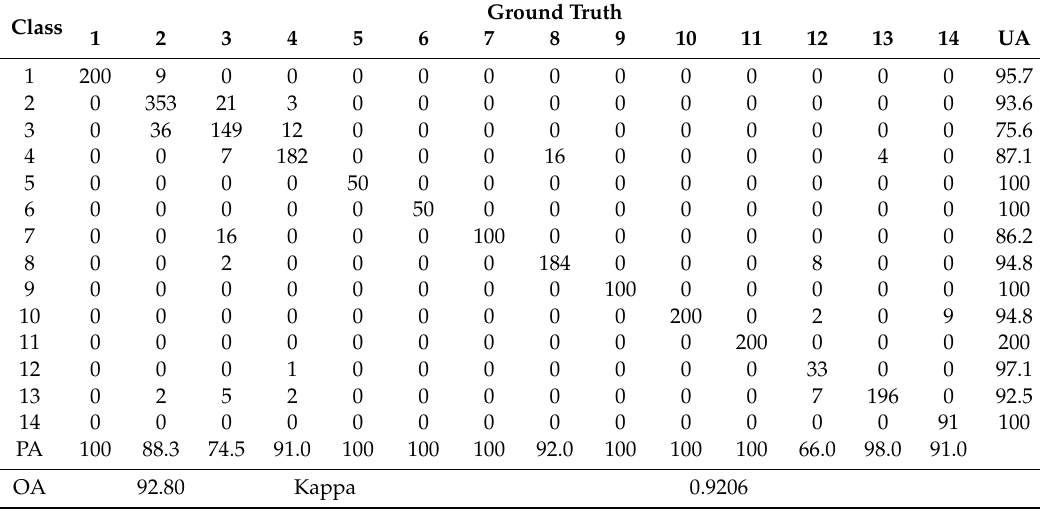
Table 4. Confusion